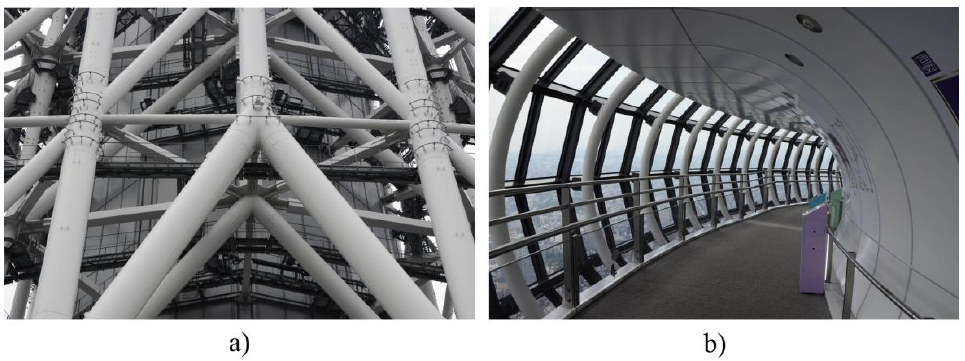
Figure 17. Tokyo Sky Tree: ( a ) An independent steel truss structure employing wide-bore high strength steel pipes; and ( b ) the spiral ramp of the Tembo Gallery in the second observation deck (photograph by authors).